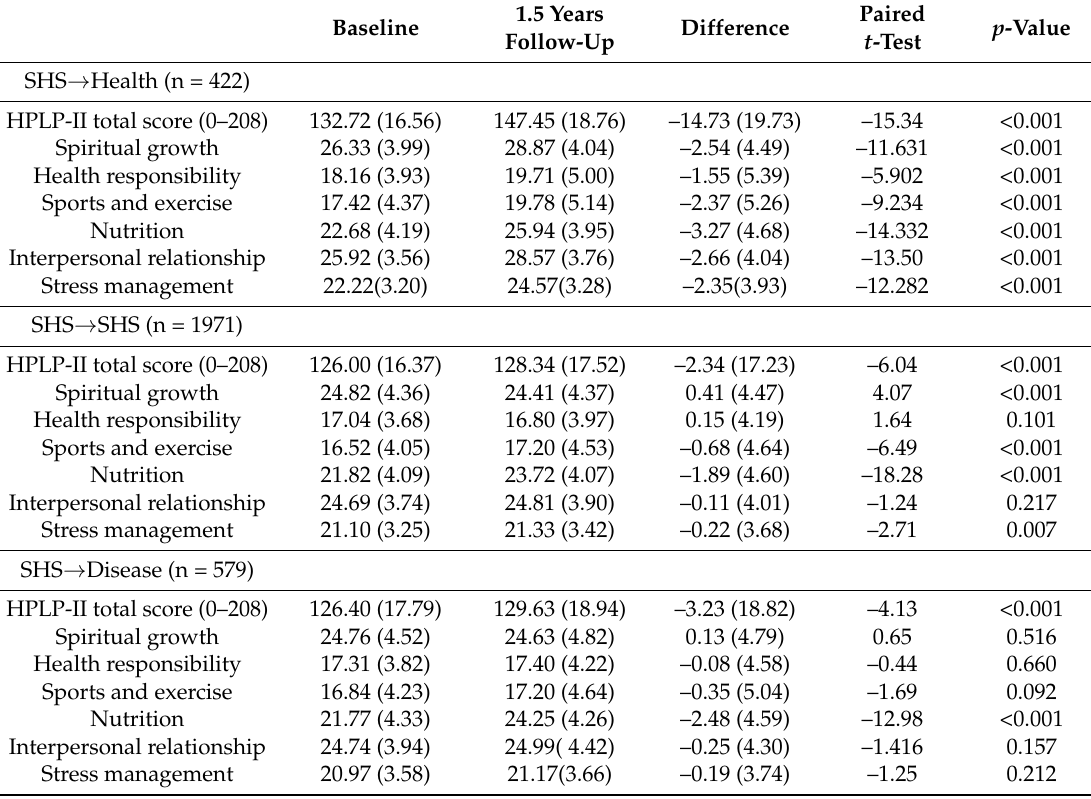
Table 5. The health status translation and the assessment of lifestyle behaviors through the study of the prospective population cohort among 2972 SHS students in 1.5 years